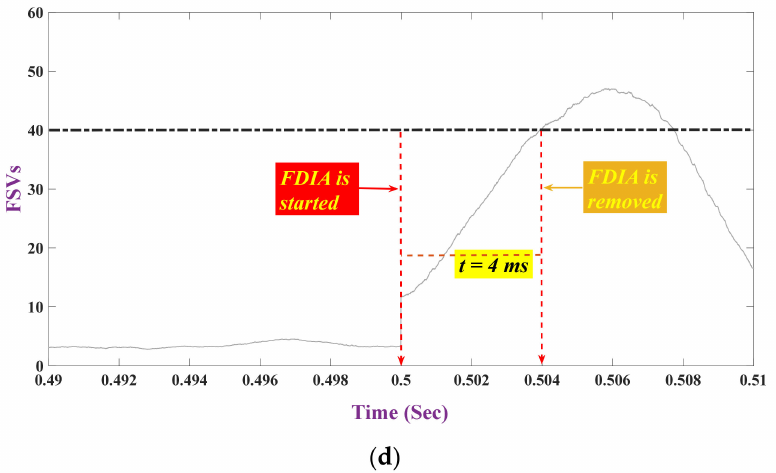
Figure 5. Instability stems from manipulating the voltage reference signal’s amplitude to simulate the FDIA: ( a ) ISMG’s voltage; ( b ) Loads current; ( c ) FSVs of signals; ( d ) Time response of FSVs scheme (FDIA is initiated at t = 0.5 s and is omitted at t = 1 s).